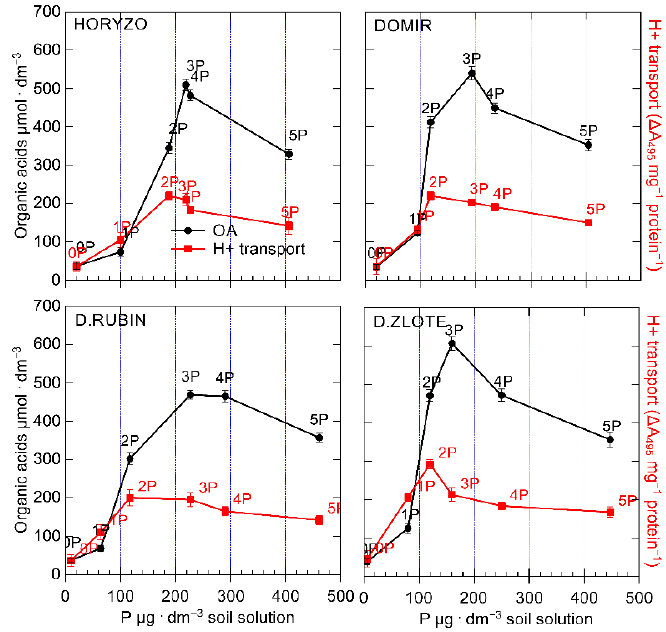
Figure 7. The level of OA exudation and proton efflux in roots of rye varieties grown on the post- flotation sediment in relation to the P concentration in soil solution. Plants were subjected to 0 (0P), 22 (1P), 44 (2P), 66 (3P), 88 (4P), and 110 (5P) mg P·kg − 1 . Soil solutions were collected, and the plasma membrane vesicles were isolated as described in Figures 3 and 4, respectively. Data represent the means of n = 9 replications ± SE.